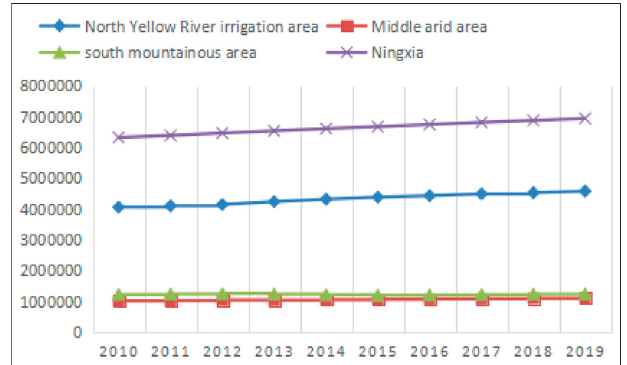
FIGURE 2 | The population growth changes of 5 cities from 2010 to